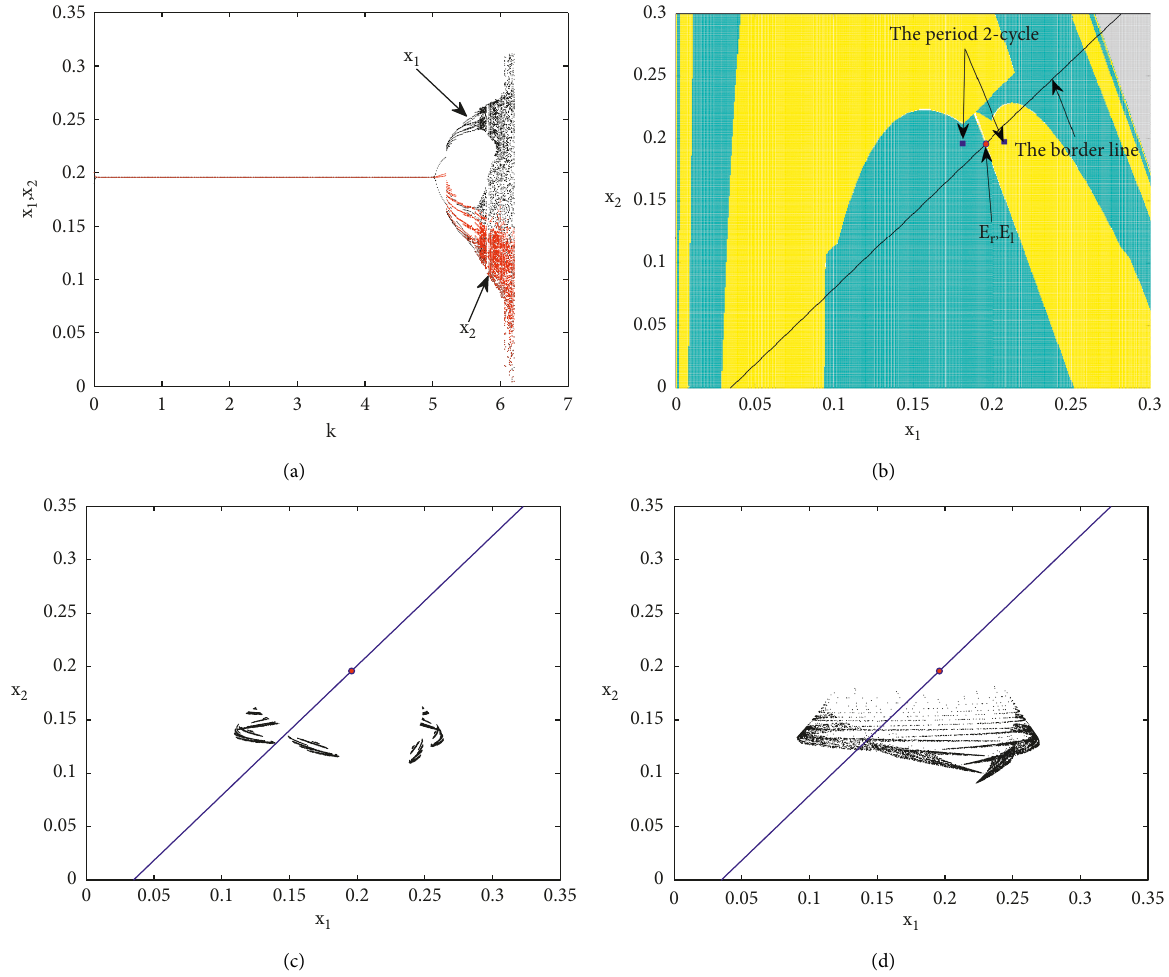
� 5 . 1. (c) Phase plane for the 2